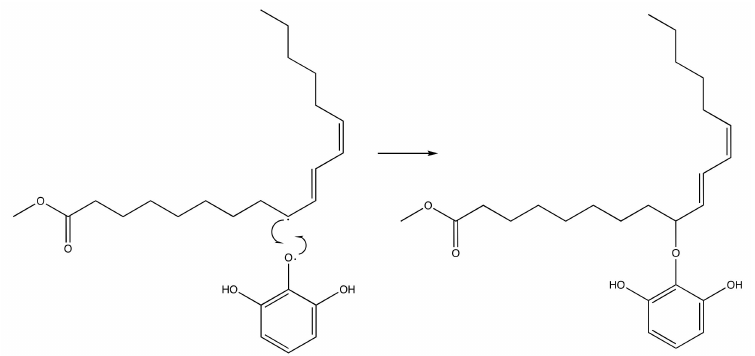
Figure 12. Radical termination mechanism of pyrogallol and methyl linoleate to form methyl (10 E ,12 E )-